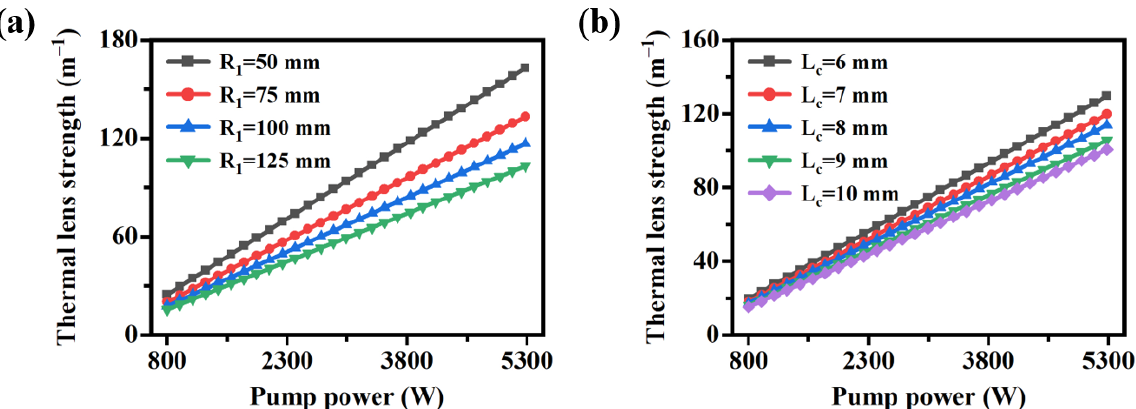
Figure 9. Relationship between thermal lens intensity and pump power at different ( a ) radii of curvature of cavity mirrors, and ( b ) crystal lengths.